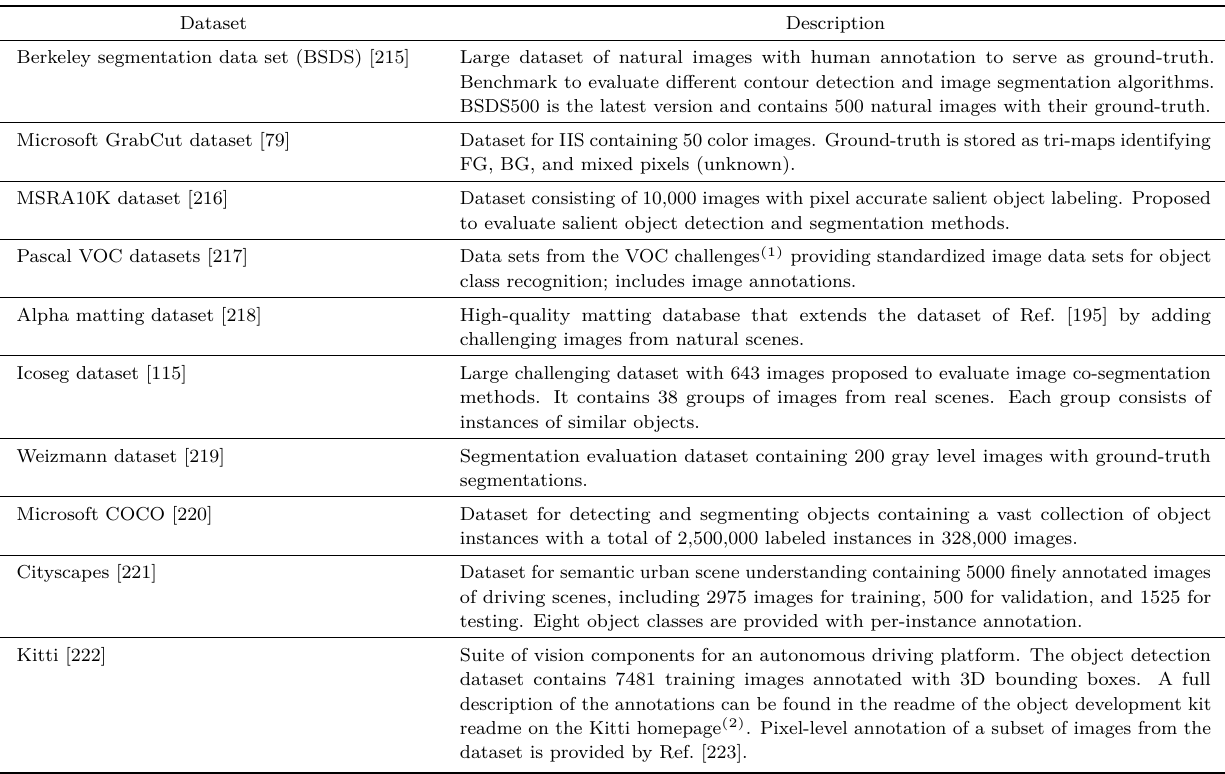
Table 1 Different datasets used in the evaluation of IIS methods